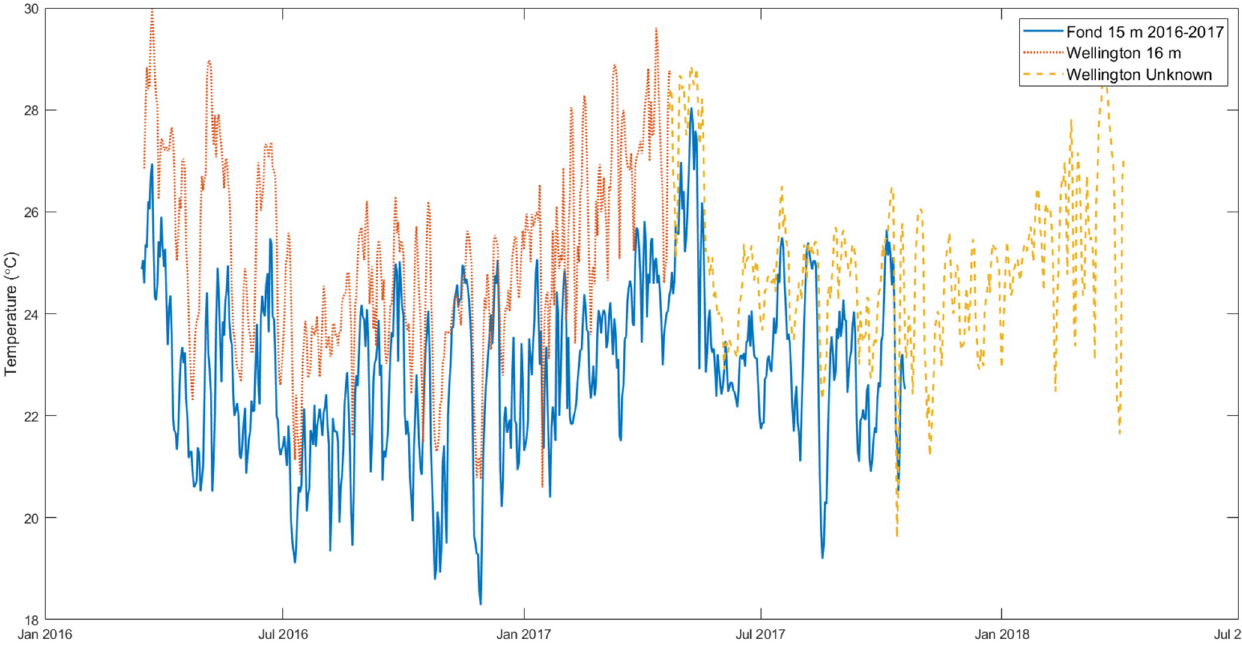
Fig 3. Daily temperature average from Wolf Island and Darwin Island. Comparison between the daily averaged logger temperature data at Wolf Island’s anchorage point (blue solid line), and loggers at Darwin’s Wellington reef at 16m (orange dotted line) and an unknown depth assumed to be around 15 m (yellow dashed